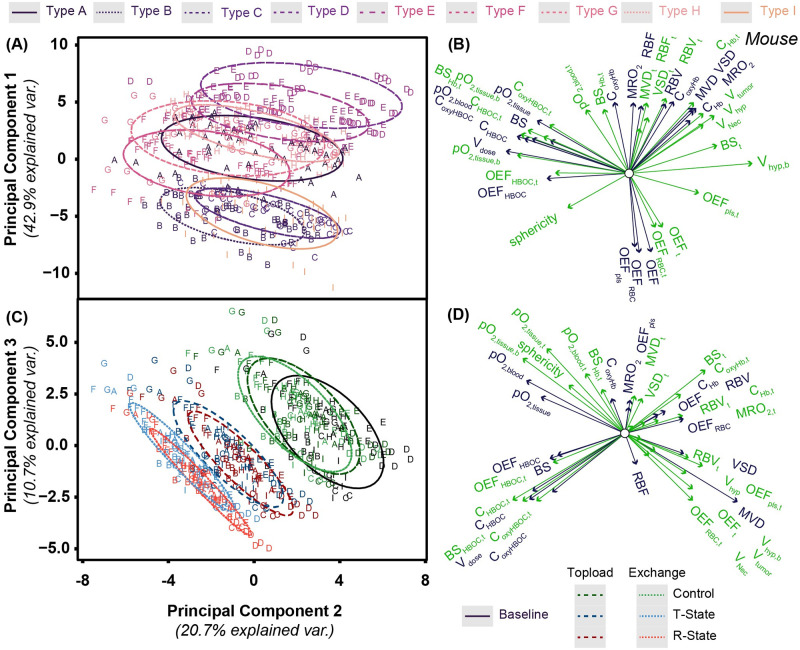
PCA biplot for principal components 1 and 2 for the analysis of the mouse model.PC scores for tissue properties and O2 delivery for each of the simulated mouse tumor treatments for (A) principal component 1 and (C) principal component 3 as a function of principal component 2. Grouping in panel A is based on tumor vascular bed type. Grouping in panel B is based on dosing type. Ellipses are drawn around each group with 68% of the normal probability. Loading plots relating how each parameter influences the corresponding principal component is shown for (B) principal component 1 and (D) principal component 3 as a function of principal component 2. Loading vectors with magnitude less than 0.5 have been excluded from this plot. Green vectors indicate tumor properties while blue vectors indicate host tissue properties. Labels on each vector indicate the corresponding tumor property.